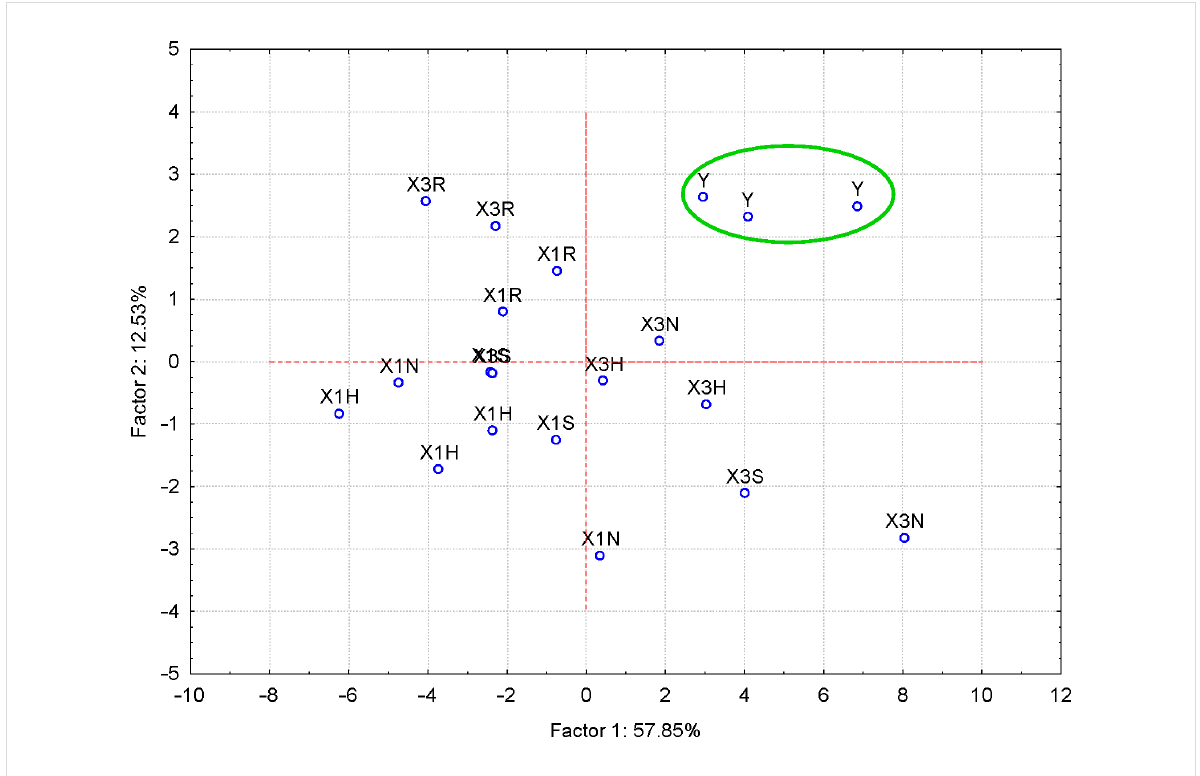
Figure 5: PC 2 versus PC 1 scores plot from the FTIR–PCA analysis of the β -CD/hazelnut oil/flavonoid ternary complexes (codes: “X1H/N/R/S” and “X3H/N/R/S” for the 1:1:1 and 3:1:1 ternary complexes with hesperidin/naringin/rutin/silymarin, respectively) and β -CD hydrate (code: “Y”); all wavenumbers and intensities of the FTIR bands were used as input variables.